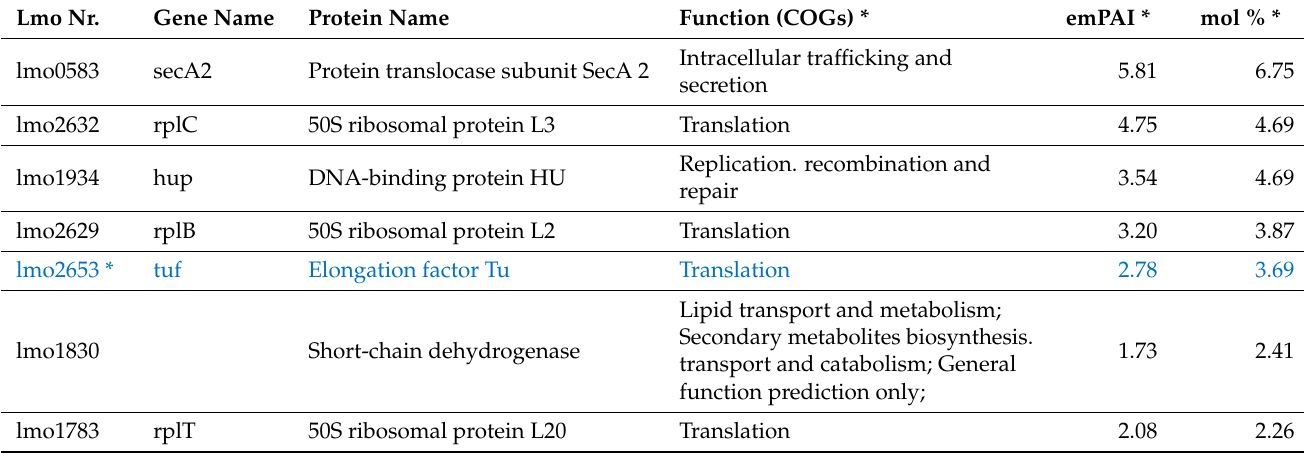
Table 1. Proteins co-isolated with SecA2. All proteins that have been described to be SecA2- dependent [5,16,30] are highlighted in blue. Glycolytic proteins are